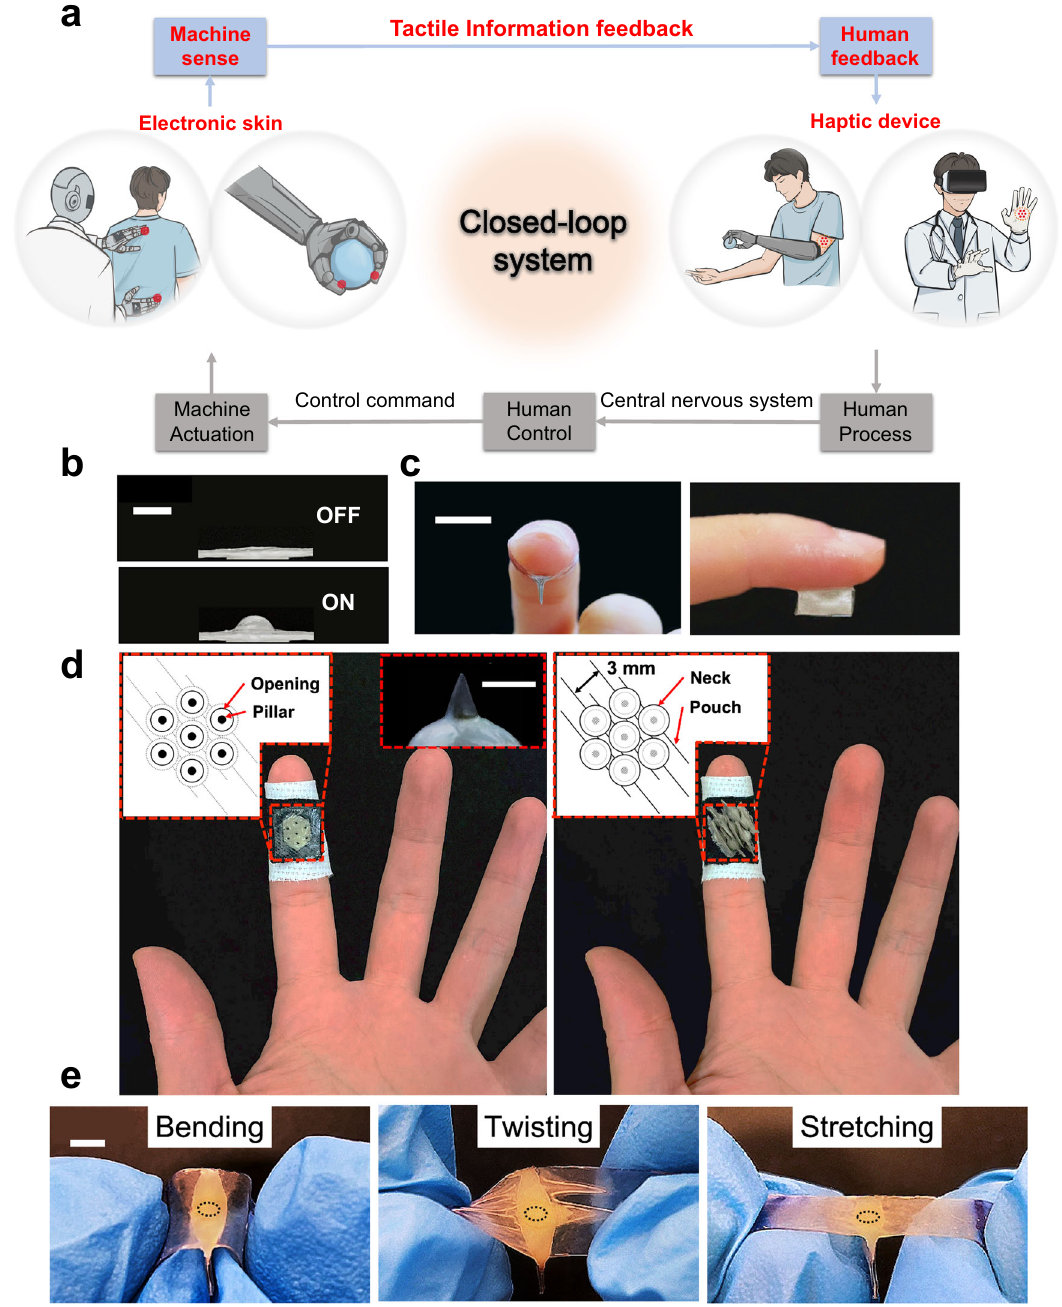
Fig. 1 Schematics and pictures of skin-integrated stretchable haptic devices. a Illustration of closed-loop human-machine interfaces. b Pictures of an actuator without pressure-ampli fi cation structures when the applied voltage is OFF and ON (Scale bar: 2 mm). c Front and side views of an actuator attached to the fi nger (Scale bar: 10 mm). d Left: top view of an actuator array integrated with the fabric. The inserts show the schematic diagram of the top view of the actuator array (left insert) and a picture of an actuator with the pressure-ampli fi cation structure under applied voltage (right insert) (Scale bar: 1 mm). Right: bottom view of an actuator array integrated with the fabric. The insert shows the schematic diagram of the bottom view of the actuator array. e Pictures showing actuators without pressure-ampli fi cation structure under bending, twisting, and stretching without applied voltage (Scale bar: 3